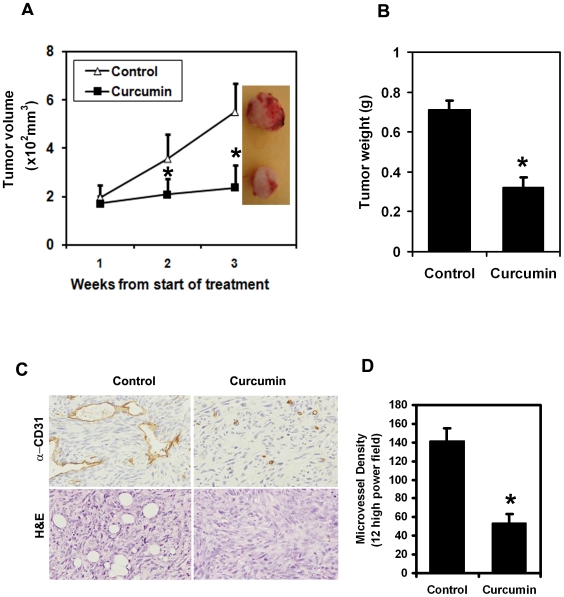
Curcumin inhibits growth of Pan02 tumor xenografts.(A) Nude mice carrying Pan02 cell tumor xenografts in the flanks were administered curcumin intraperitoneally for 3 weeks. There was a significant reduction in tumor size from curcumin-treated animals when compared to untreated controls (*p<0.05). (B) Curcumin treatment resulted in significantly lower tumor weight when compared to controls (*p<0.05). (C) Tumor sections were stained for CD31, an endothelial cell specific surface marker and with hematoxylin and eosin (H&E). A representative figure is presented showing significant reduction in microvessels. (D) The number of microvessels in the tumor tissues were counted in 12 high power fields and averaged. Data shows that microvessel density was significantly reduced in the xenografts of curcumin treated animals (*p<0.05).